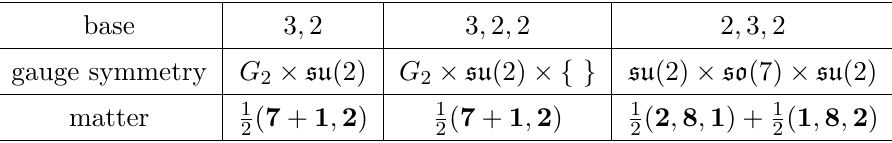
Table 18 . Three higher-rank